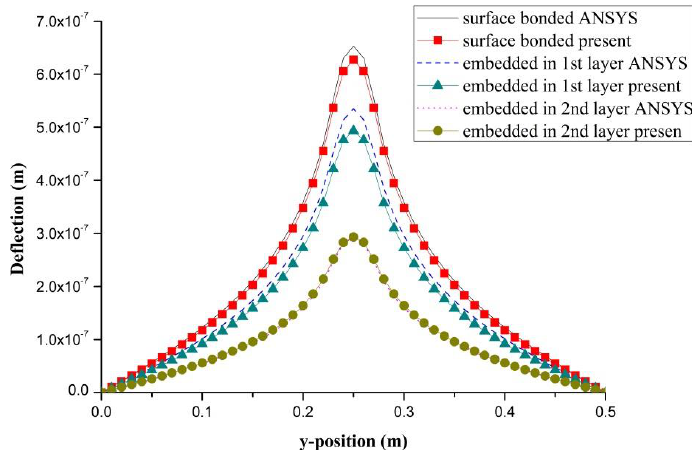
Figure 14. Deflection along the vertical line ( x = 0.25 m) of the composite laminate plate induced by a PZT actuator embedded in different depths.